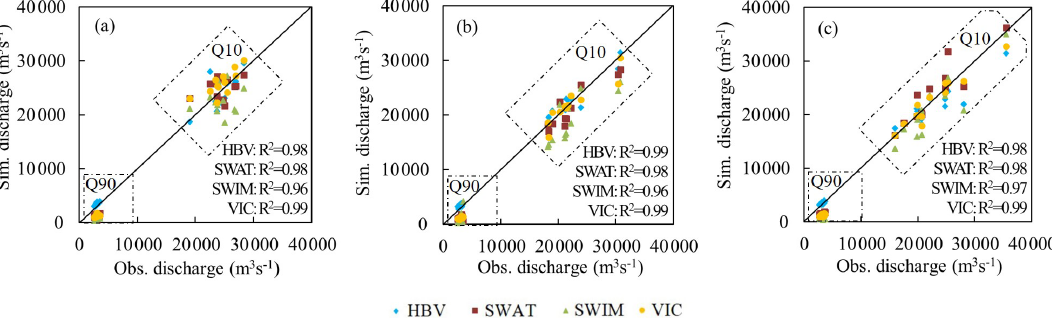
Figure 6. Comparison of the simulated and observed Q 10 and Q 90 percentiles at the Cuntan station in the calibration period 1979–1990 (a) and validation periods 1967–1978 and 1991–2002 (b, c) .